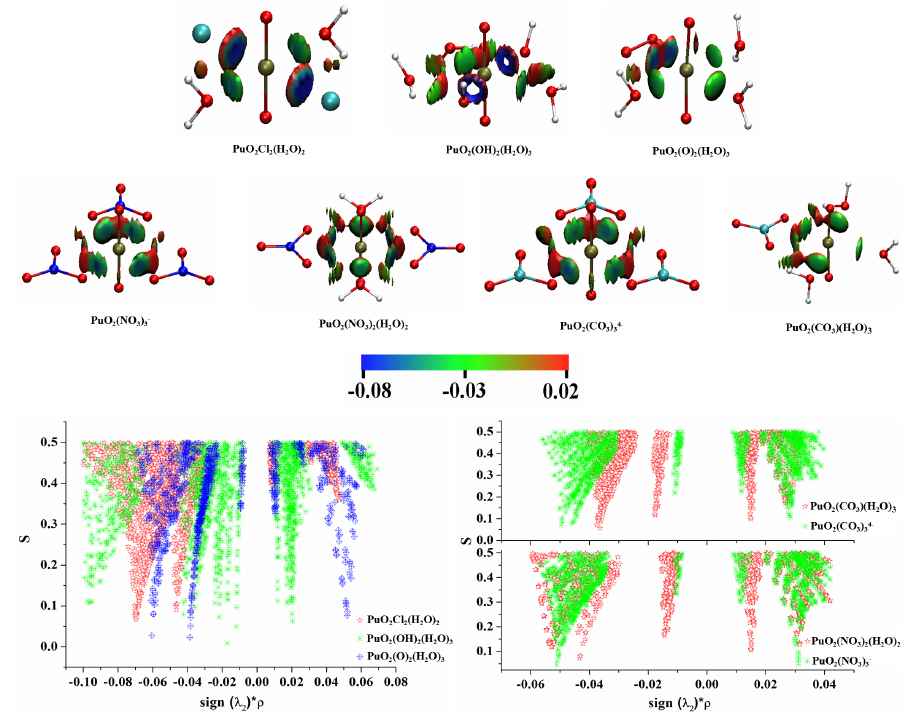
Figure 5. 2D scatter plots of the RDG vs. sign( λ 2 ) ∗ ρ and corresponding 3D isosurfaces were generated with s = 0.5 for Plutonyl (VI) complexes with Cl − , OH − , O 2 −